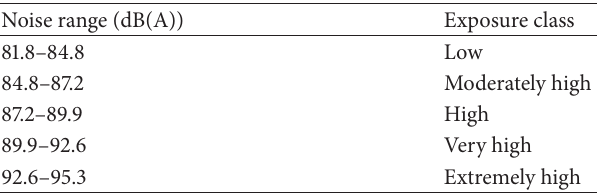
Table 5: Night-time exposure